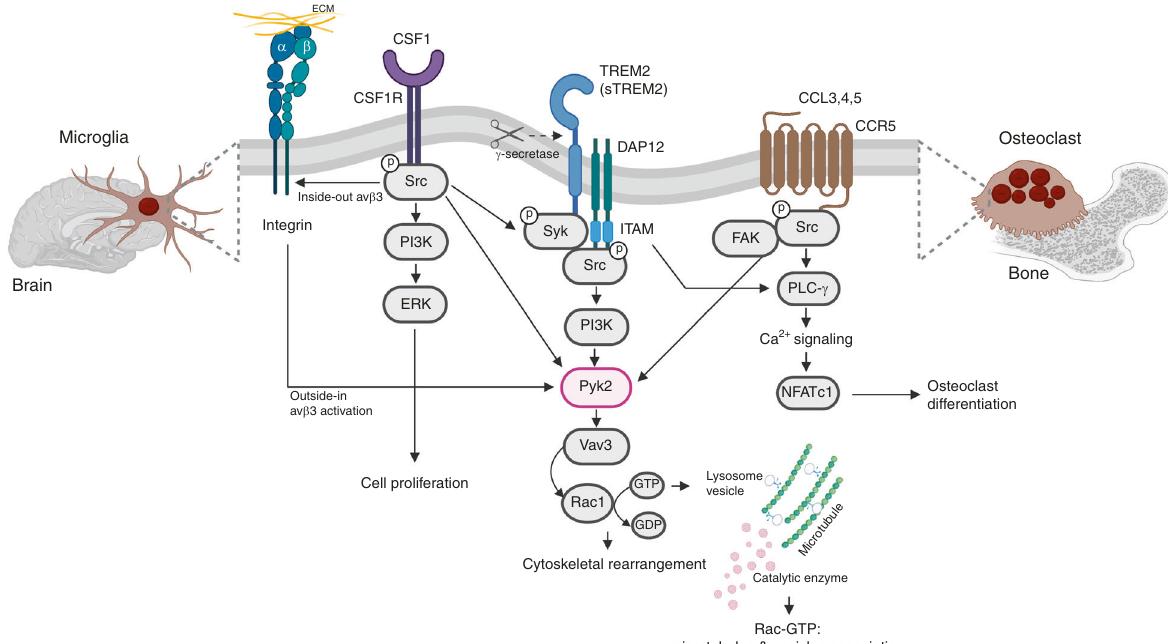
Fig. 2 TREM2/DAP12-, CSF1/CSF1R-, and CCR5 pathways in osteoclasts and microglia. Once ligands bind to TREM2, two tyrosine residues in the immunoreceptor tyrosine-based activation motif (ITAM) of DAP12 are phosphorylated, which in turn recruits Syk kinase to activate downstream molecules such as Src tyrosine kinase and phosphatidylinositol 3-kinase (PI3K). The soluble form of TREM2 (sTREM2) is generated by ɣ -secretase, which activates PI3K, extracellular signal-regulated protein kinase (ERK), and NF-kB. Src, the main effector of CSF1R, is a tyrosine kinase that phosphorylates the ITAM tyrosine residues. CCL3/4/5 binding to CCR5 activates G protein and multiple downstream signals such as Src, PLC- ɣ and PI3K. PI3K triggers the tyrosine phosphorylation of focal adhesion complex components such as Pyk2, paxillin, Crk, and p130Cas, leading to interaction with Vav. Pyk2-Vav interaction may control Rho family GTPase activation, thereby driving localized actin polymerization that stabilizes contacts with matrix and/or promote into multinucleated osteoclasts. Although the bone resorption capability of TREM2-/DAP12-de fi cient osteoclasts was impaired in vitro, the bone of NHD patients is osteoporotic due to the loss of trabeculae bone. Given these pathologic discrepancies between genetically de fi cient/cultured osteoclasts in vitro and local osteolytic phenotype in NHD patients, the role of TREM2/DAP12 in regulating osteoclastogenesis could be context speci fi c. One possibility is that enhanced bone loss in vivo can be explained by systemic or local factors (endocrine, paracrine, etc.) affecting the differentiation or activation of osteoclasts in situ. A similar osteoporotic phenotype in NHD observed in Trem2 -de fi cient mice. 53 Alternatively, TREM2/ β -catenin pathway regulated bone mass by modulating the rate of osteoclastogenesis. 53 Deletion of either TREM2 or β -catenin inhibits the CSF-1-induced proliferation of osteoclast precursors but accelerates their differentiation into mature osteoclasts, which ultimately causes osteoporotic pheno- type like NHD. Understanding the role of osteoclasts in the bone phenotype in NHD is yet to be elucidated while TREM2/DAP12 pathway is an attractive target for treatment of osteoporosis.